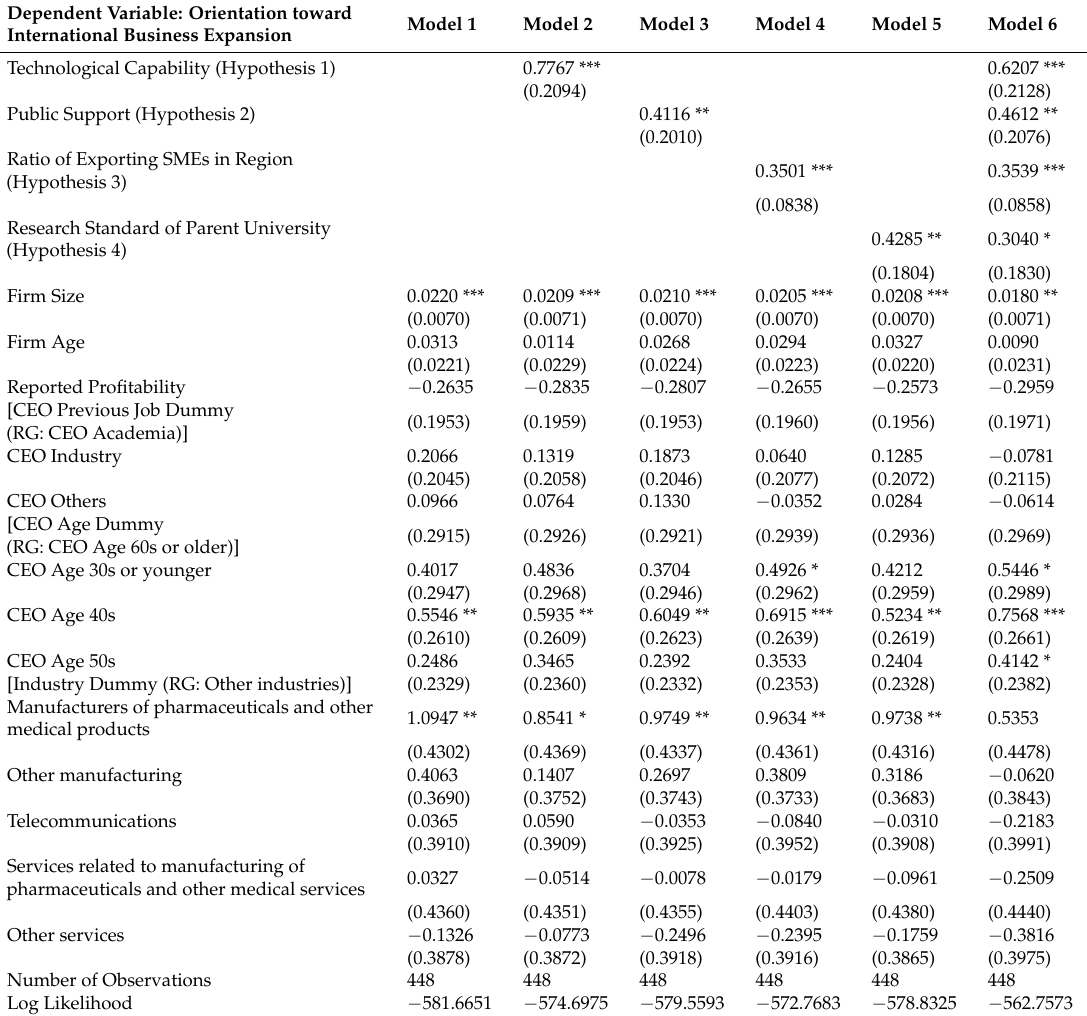
Table 3. Determinants of orientation toward international business expansion (ordered logit